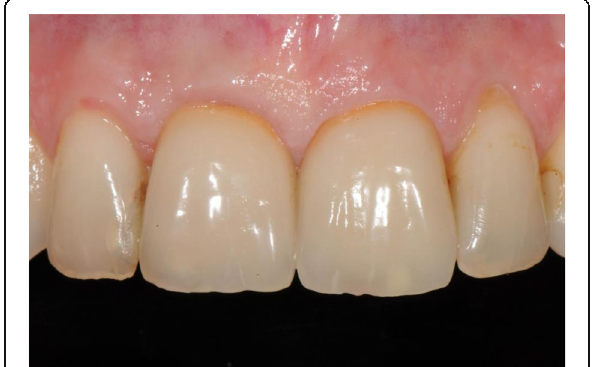
Fig. 18 Finalized prosthetic restoration after 1